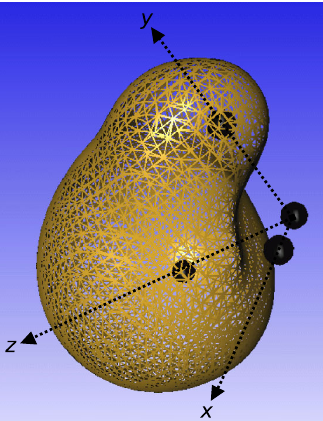
FIG. 6. Skeleton and isocontour representation of the funda- mental state of the toy model chiral molecule employed in the TDSE calculations.